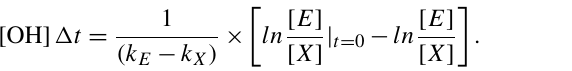
Table 1. Average, range and standard deviation of concentrations for NO x (i.e., NO and NO 2 ) and the eight most abundant volatile organic compounds (VOCs) measured at the Heshan site, together with a sum of the mixing ratios for each hydrocarbon category (i.e., alkanes, aromatics and